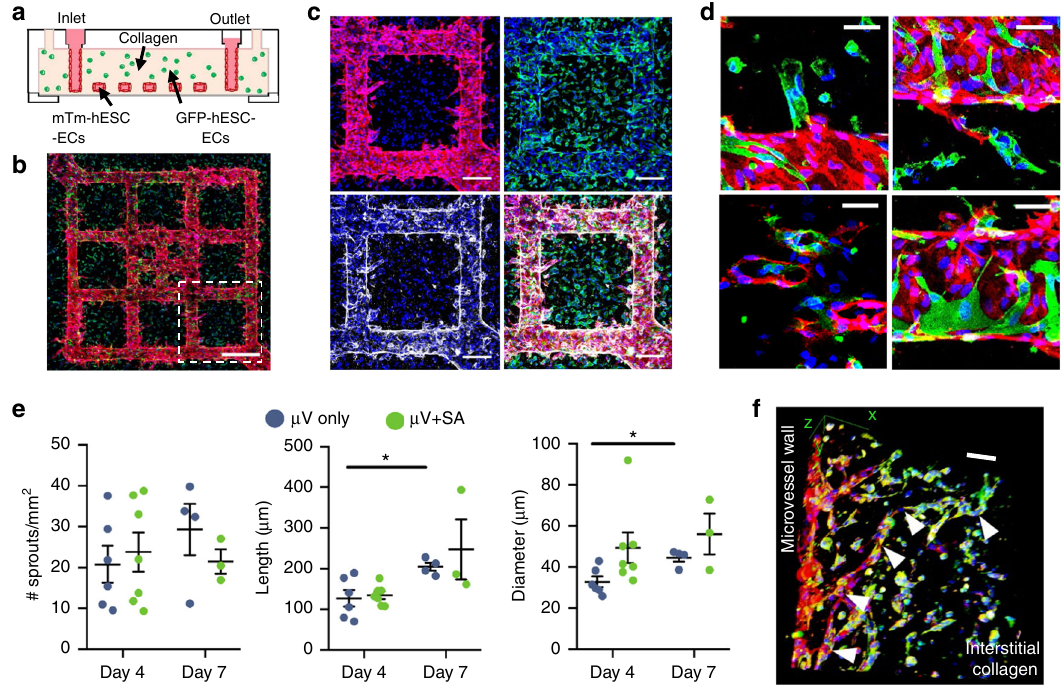
Fig. 1 In vitro anastomosis of human embryonic stem cell-derived endothelial cells (hESC-ECs) in engineered microvessels ( µ Vs). a Schematic of in vitro culture device for μ V + SA constructs: mTm-hESC-EC µ Vs formed via perfusion and attachment with bulk-seeded GFP-hESC-ECs in the surrounding collagen gel. b Maximum intensity projection of stitched large image confocal z -stack of μ V + SA construct cultured for 4 days and stained for DsRed (red) and GFP (green) to detect mTm- and GFP-expressing hESC-ECs, respectively. Scale bar, 500 μ m. c Outlined region (white box) in b stained for DsRed (red, top left), GFP (green, top right), and VE-cadherin (white, bottom left). Merged image, bottom right. Scale bar, 200 μ m. d High magni fi cation images of GFP-hESC-ECs (green) integrated with mTm-hESC-EC (red) patterned vessel in μ V + SA constructs. Scale bar, 50 μ m. e Quantitation of sprouts from patterned µ Vs by sprout density (no. of sprouts per vessel surface area), sprout length, and sprout diameter in μ V only (blue circles) and μ V + SA (green circles) constructs after 4 days and 7 days of culture. N = 6, 7, 4, and 3 biologically independent samples for D4 μ V only, D4 μ V + SA, D7 μ V only, and D7 μ V + SA, respectively. p = 0.011 for length and p = 0.007 for diameter for D4 μ V only and D7 μ V only, p > 0.05 for all others (two-tailed t test). f 3D view of GFP + de novo lumen integrated with mTm + microvascular sprout (white arrowheads) stained for CD31 (red) and GFP (green). Scale bar, 100 μ m. Representative images for b – d , f from seven biologically independent samples of D4 μ V + SA, with similar results. Hoechst-stained nuclei, blue. Error bars, mean ± SEM. * p < 0.05 determined using two-tailed t test. D4 after 4 days of culture, D7 after 7 days of